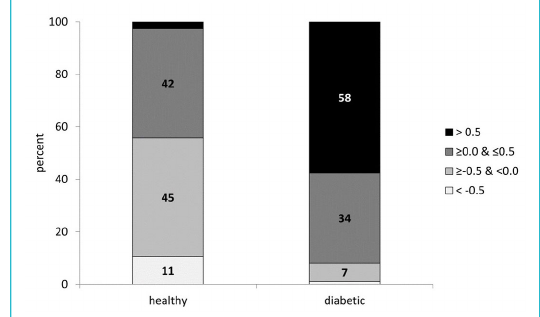
Figure 3: Percentage of participants in each glycation gap catego- ry. Diabetic participants clearly exhibited a trend towards higher glycation gap categories. The grey shading darkens as the glyca- tion gap changes from below zero to above zero, reflecting the im- pairment of glycaemic